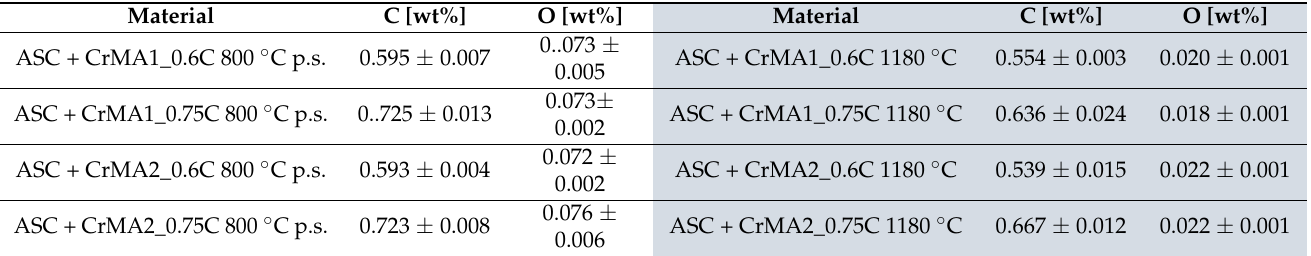
Table 2. C and O measurements. Left (white): material pre-sintered at 800 ◦ C for 1 h in N 2 /H 2 , Right (grey): material sintered at 1180 ◦ C with 10 K/min heating ramp held for 30 min in N 2 /H 2 .